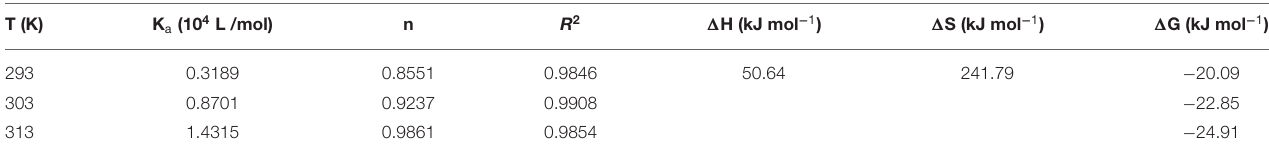
TABLE 2 | Binding parameters and thermodynamic parameters of GSPI–lutein system at different temperatures. T